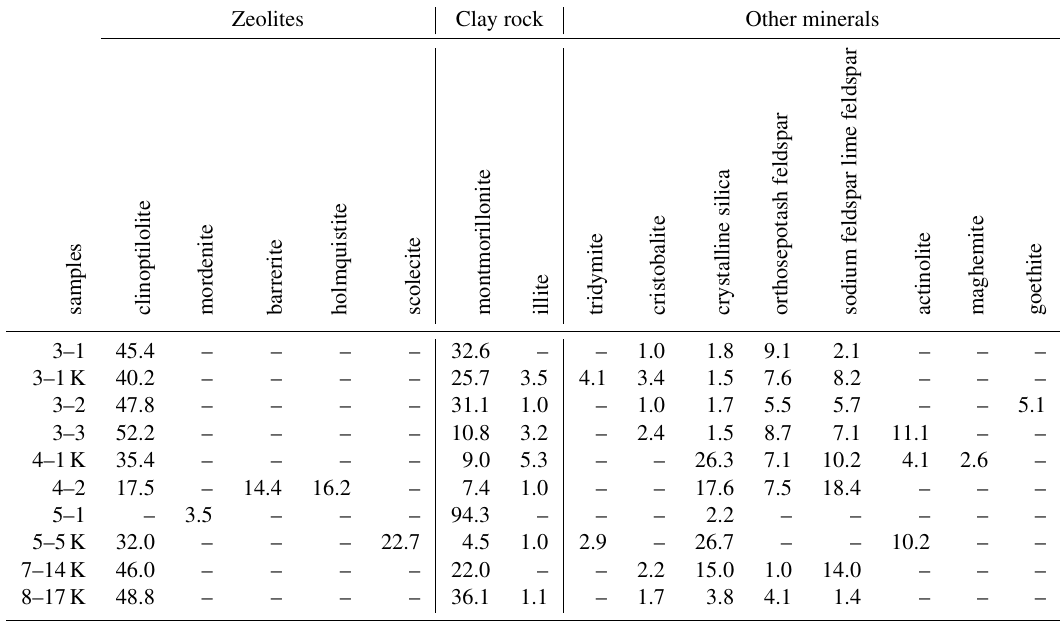
Table 1. The results of the quantitative X-ray phase analysis of kudurites and source bedrock. Zeolites Clay rock Other